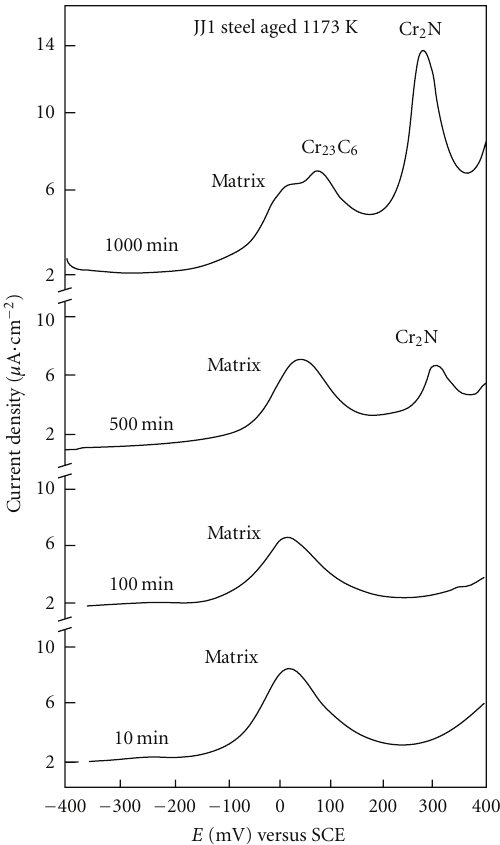
Figure 5: Anodic polarization curves of JJ1 steel aged at 1173K for 10, 100, 500, and 1000min.